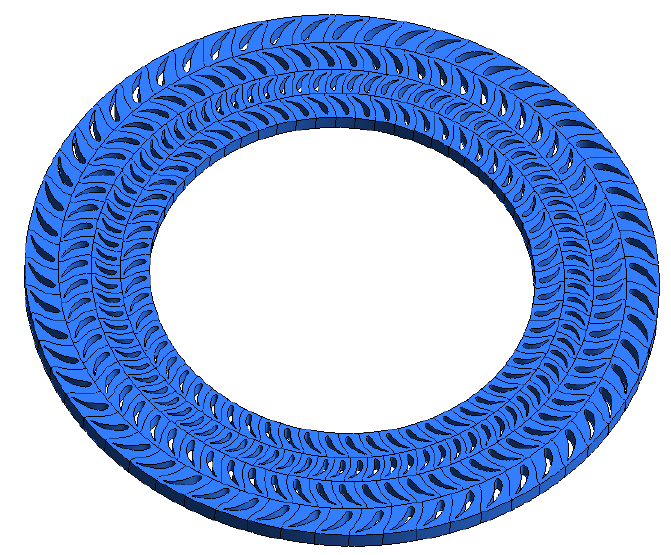
Figure 7. Full geometry of the two-stage radial outflow turbine.